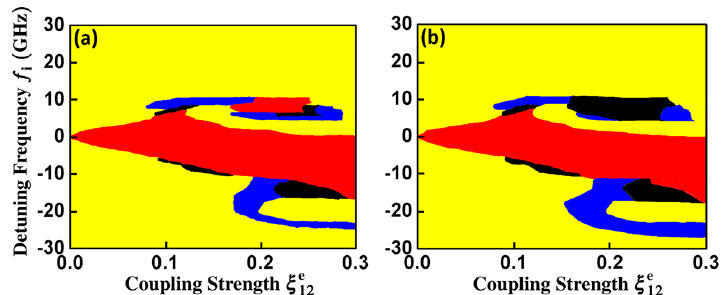
Figure 8. Maps of dynamical states for ( a ) LD1 and ( b ) LD2, respectively, in the mutually coupled laser system when ξ e = 0.01. Regions of mutual injection locking, P1 dynamics, P2 dynamics, 21 and chaos are marked by red, yellow, blue, and black,